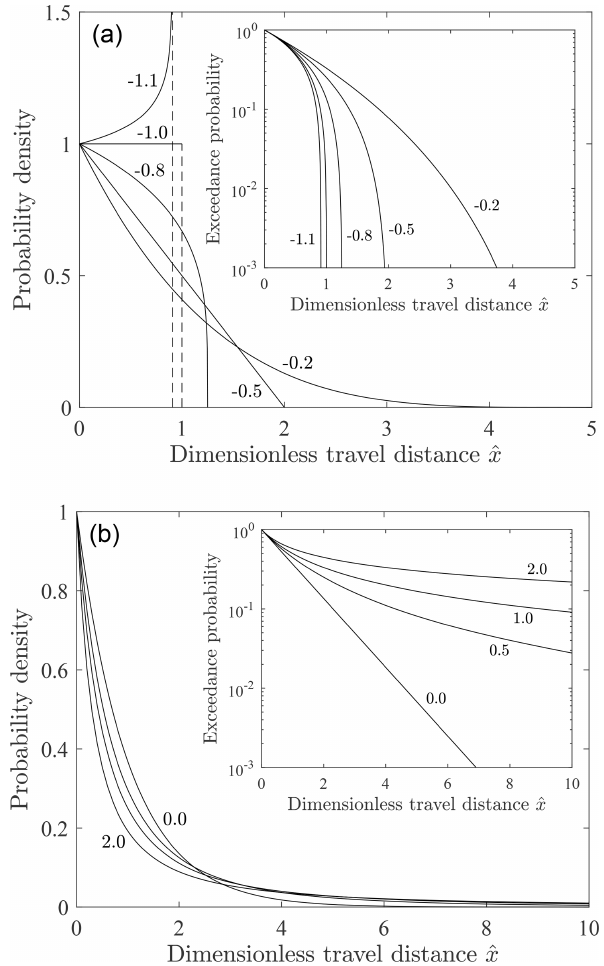
Figure 4. Plot of probability density f ˆ x ( ˆ x ) versus travel distance ˆ x for scale parameter b = 1 and different values of the shape parame- ter a for (a) a < 0 and (b) a ≥ 0 with associated exceedance prob- ability plots (insets). Compare with Fig. 1 in Hosking and Wal- lis